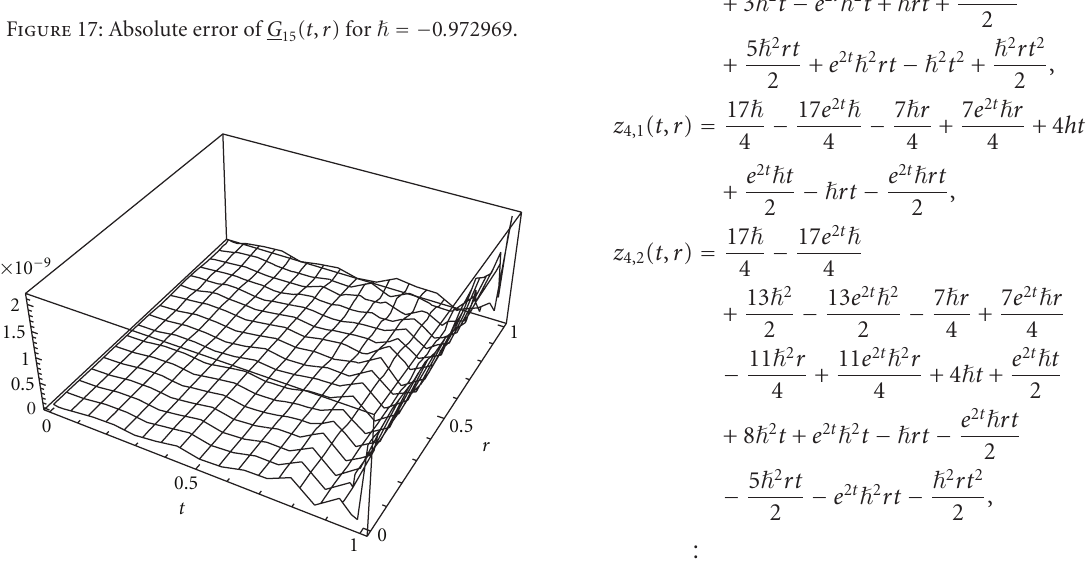
Figure 17: Absolute error of G